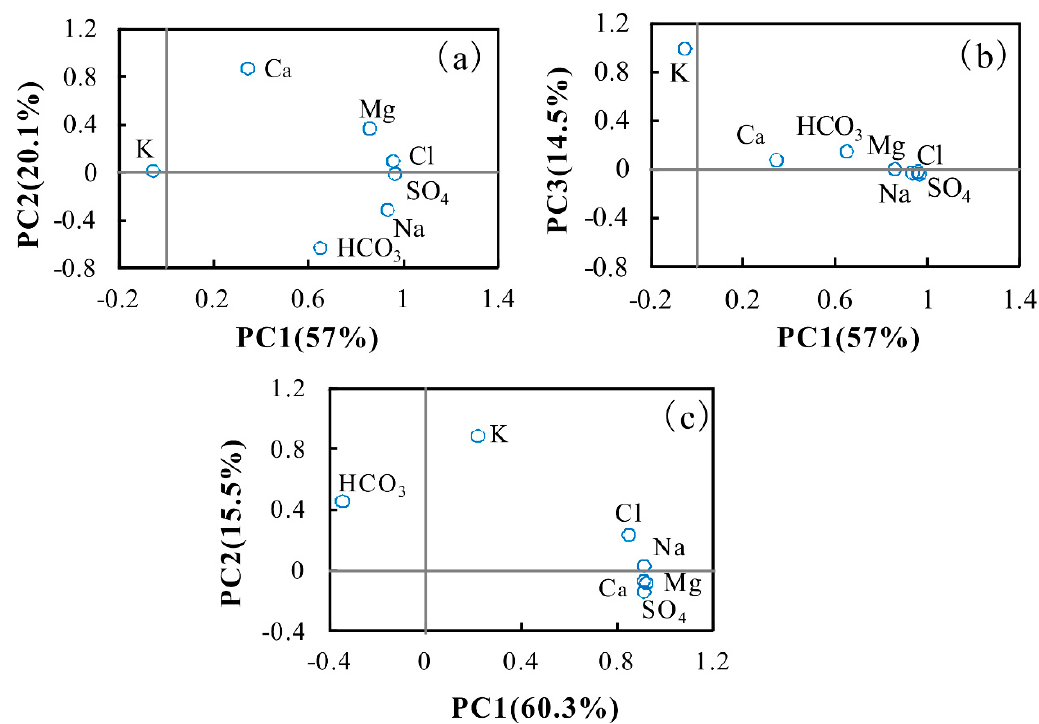
Figure 4. Plot of principal component loading for shallow groundwater samples ( a and b ) and intermediate-deep groundwater samples ( c ).